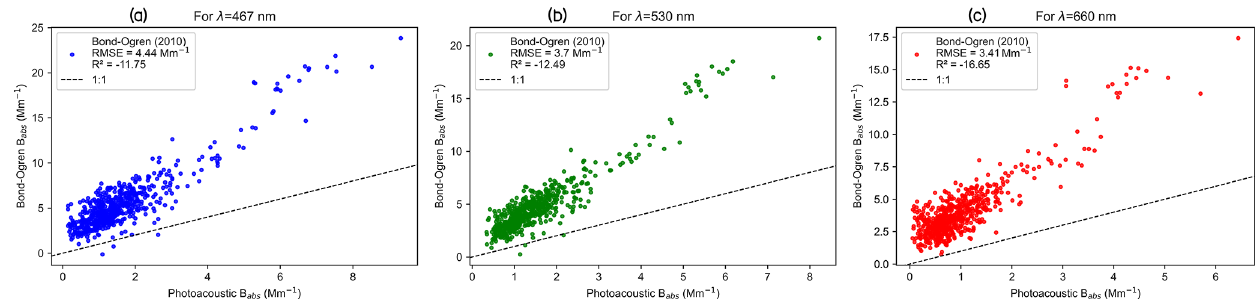
Figure 3. Comparison between PSAP absorption coefficients, corrected for using the Virkkula algorithm with revised coefficients, and the reference PASS absorption coefficients measured at the SGP site corresponding to the (a) 467nm, (b) 530nm, and (c) 660nm wavelengths.